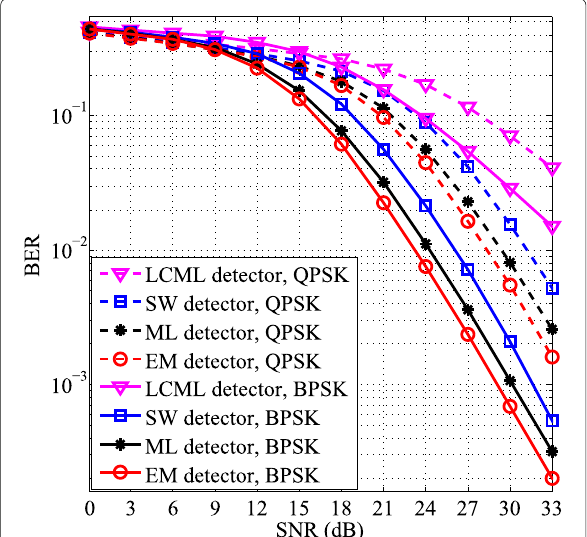
Fig. 2 Comparison of BER performance for MM-OFDM-IM ( n = 8,